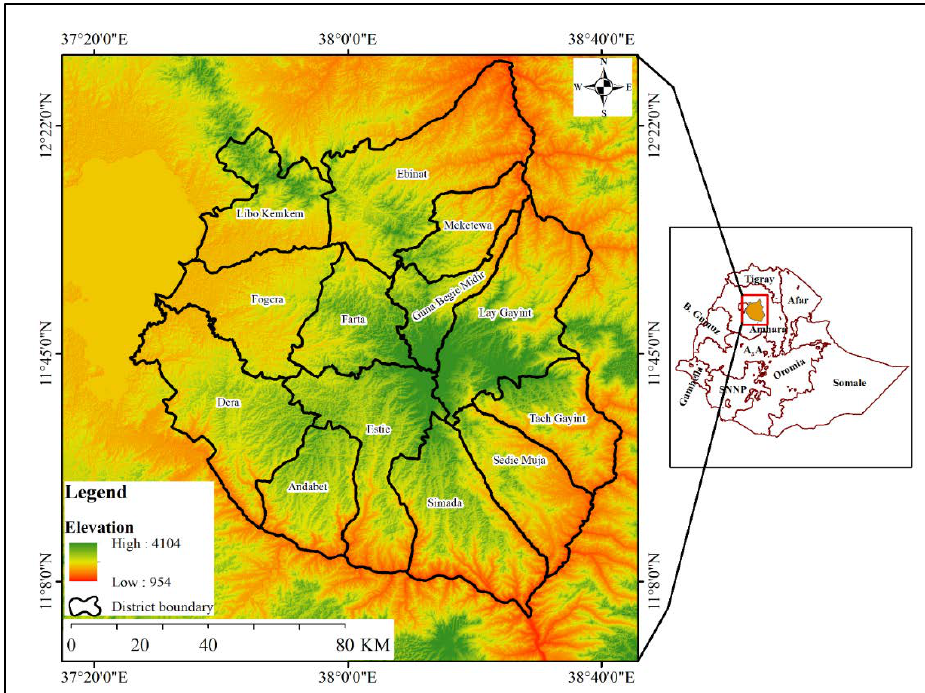
Figure 1. Location map of the study area.